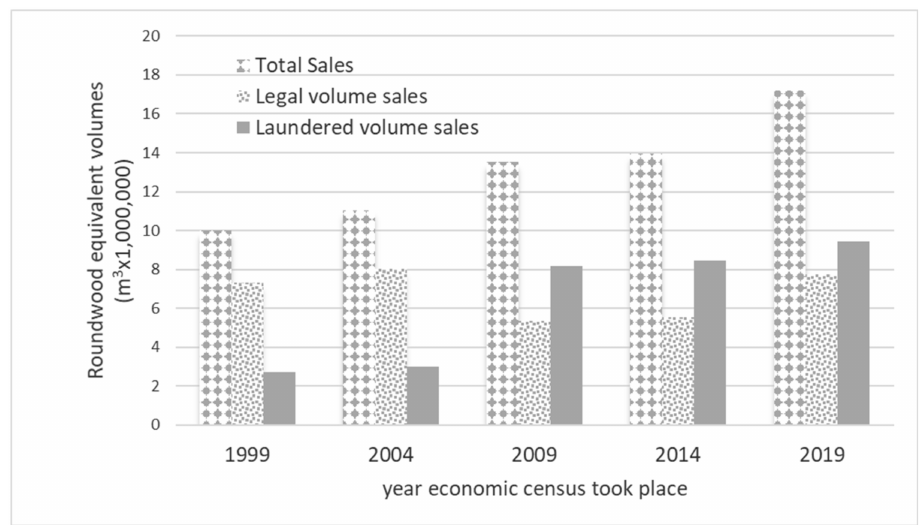
Figure 3. WBA estimates of illegal logging. Laundered volume sales are estimated as the difference between total sales and legal volume